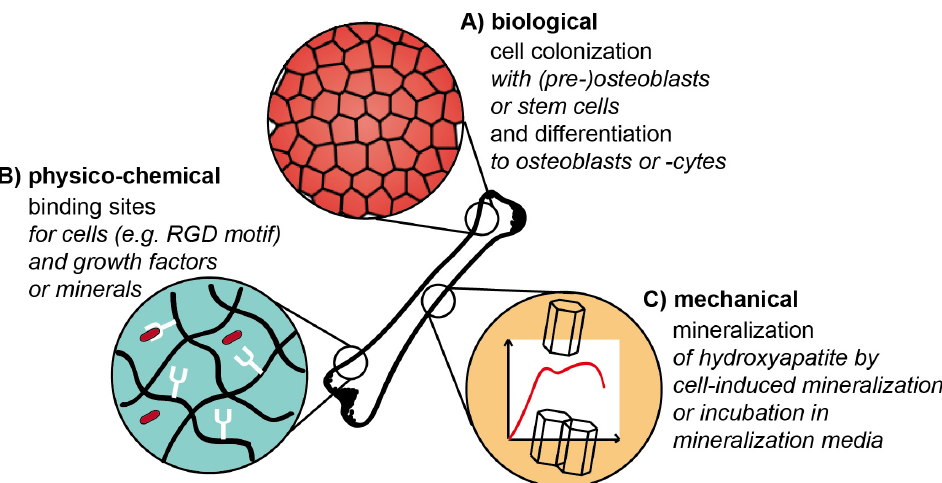
Figure 3. Illustration of biological, mechanical and physico-chemical factors of scaffold materials relevant for hard tissue engineering. ( A ) Media, growth factors, etc. are needed for tissue-specific cell colonization and differentiation on artificial scaffolds. ( B ) Materials/scaffolds have to provide binding sites for cells, factors and minerals. ( C ) Biomineralization is necessary to gain composite materials with adopted mechanical properties (such as stiffness, etc.).